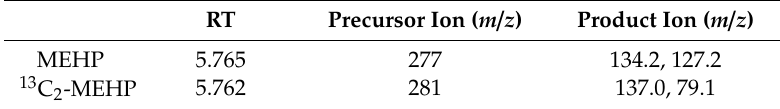
(Table 3) by a 95:5 ratio of mobile phase solvents. Table 3. MRM transition and retention time of